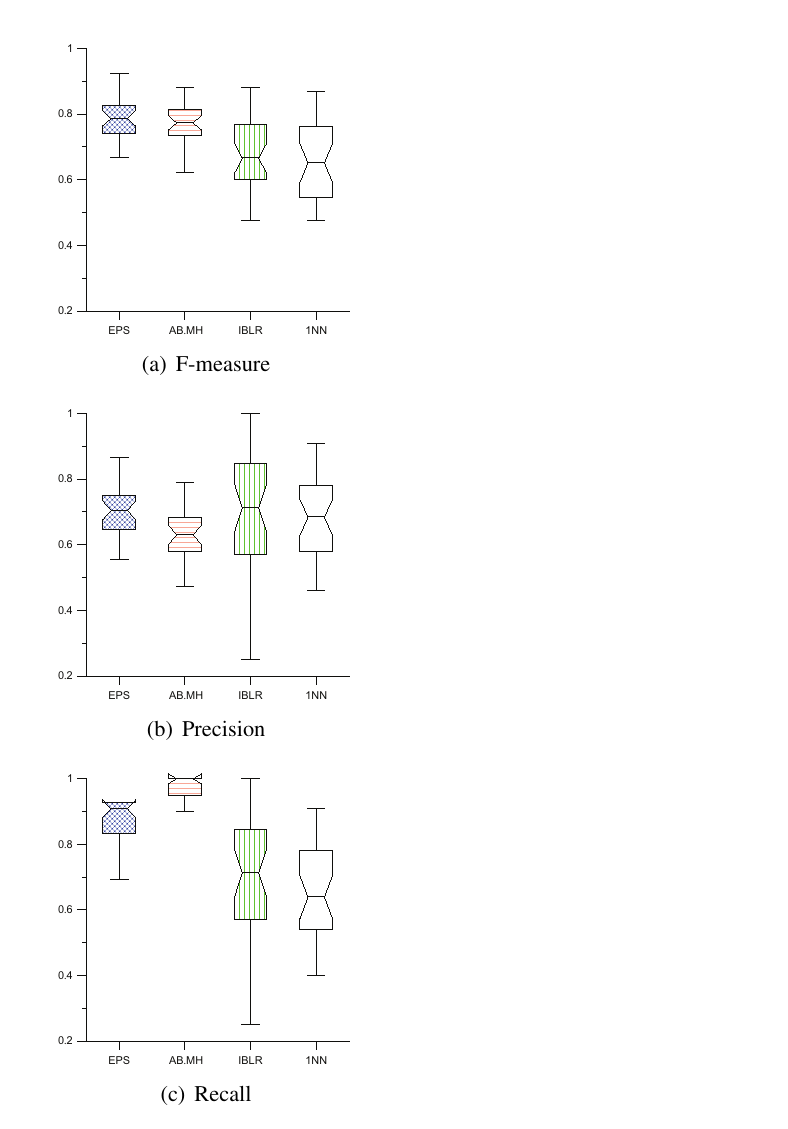
Figure 2: Box plots for a sample of n=32 data sets. The box bounds the IQR divided by the median, and Tukey-style whiskers extend to a maximum of 1.5 x IQR beyond the